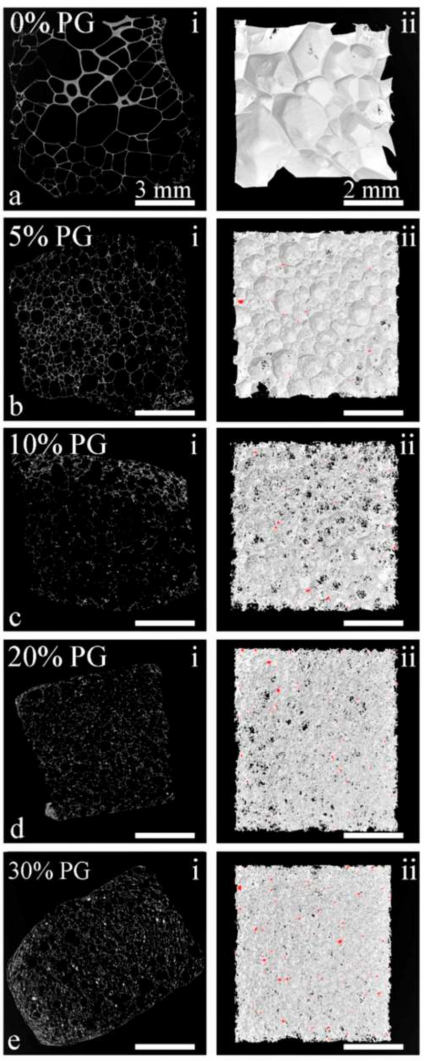
Figure 11. Micro-CT images of the SSF fabricated foams. ( a ) PDLLA, ( b ) PDLLA-5PGP, ( c ) PDLLA- 10PGP, ( d ) PDLLA-20PGP, ( e ) PDLLA-30PGP. Note that, i and ii represent 2D and 3D images, respectively. The scale bars of the images on the left and right columns are 3 mm and 2 mm, respectively. Obtained from reference [150]. Copyright @ 2020, The Authors,